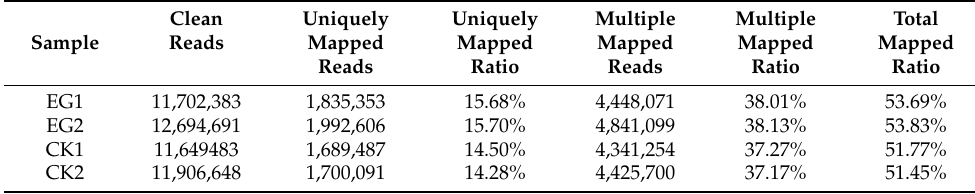
Table 2. Sample sequencing data quantity vs.